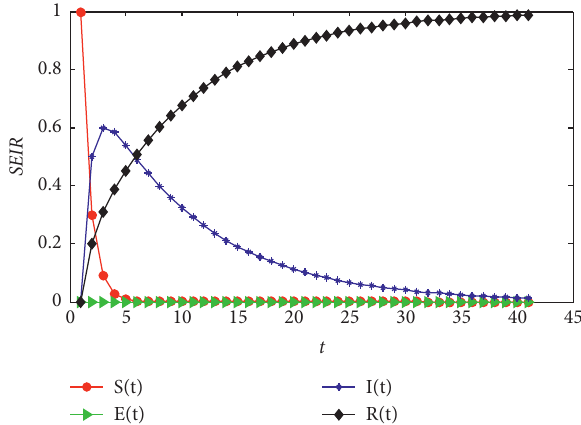
Figure 5: Change trend of SIR model (when μ 1 � 0, μ 2 � 0.5, μ 3 � 0.2 and c � 0.1, the change of four independent states of the credit subject trend over time).